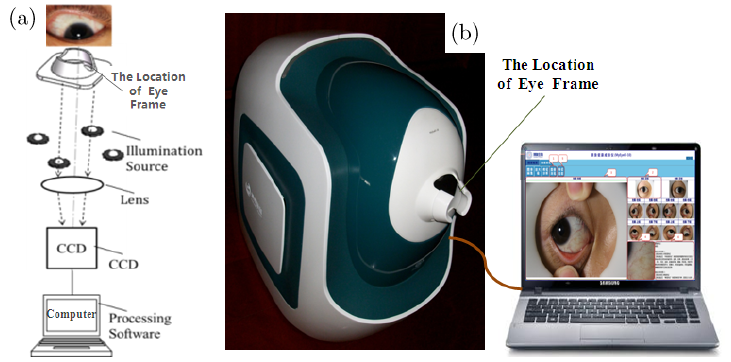
Fig. 2. (a) Schematic diagram and (b) photo of the askiatic imaging